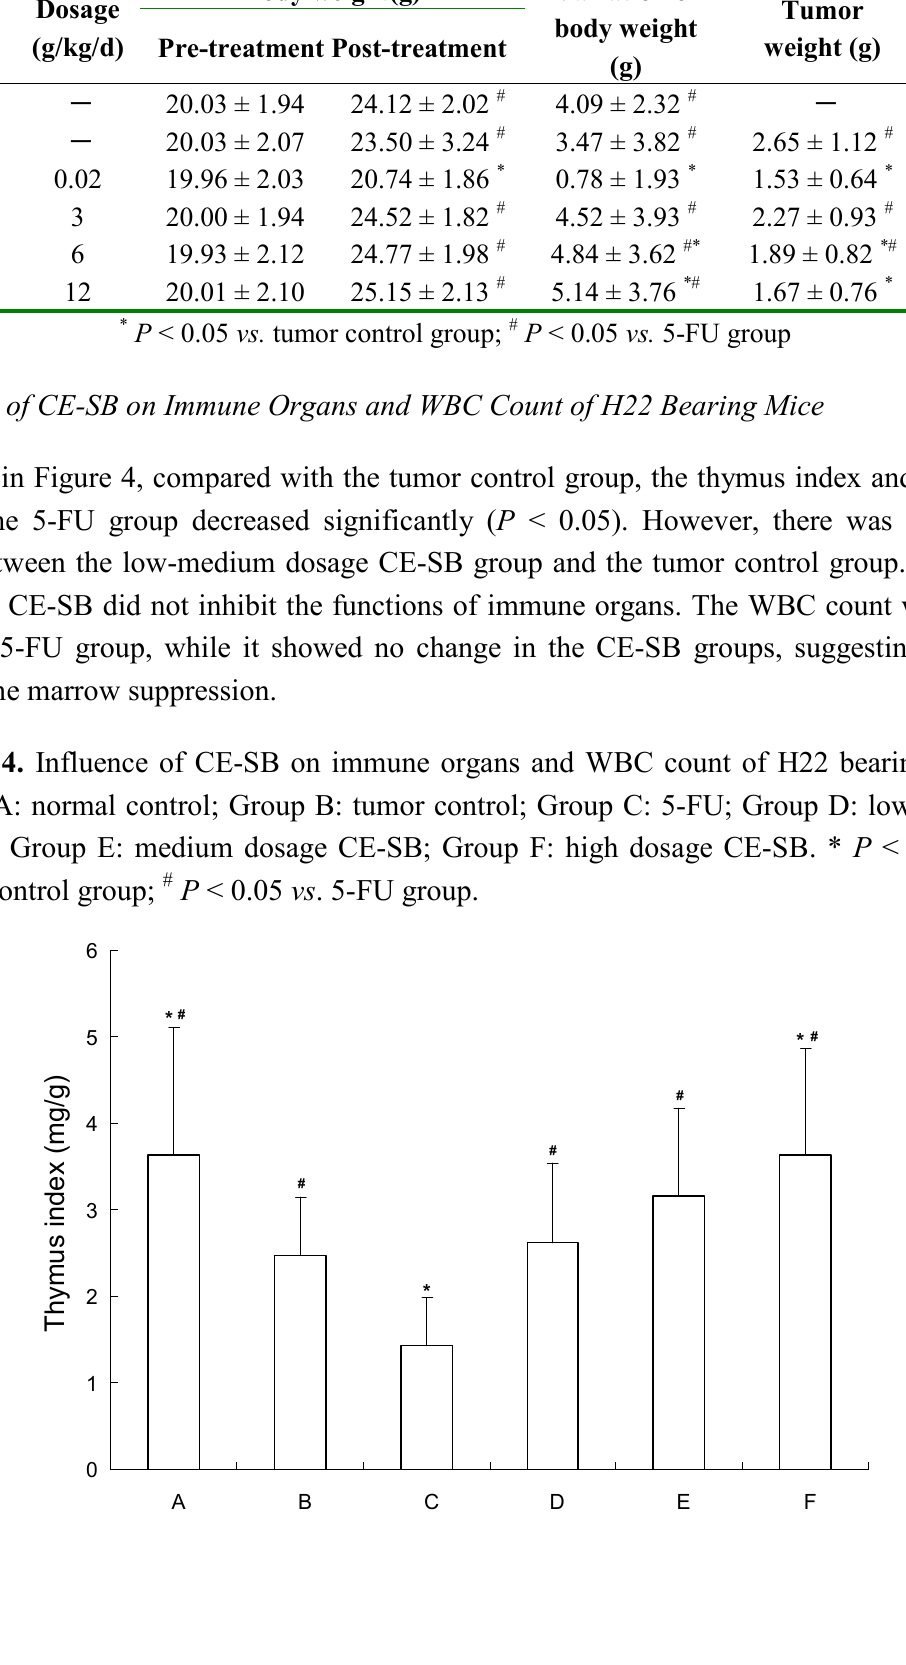
Table 1. Effects of CE-SB on body weight and tumor weight of H22 bearing mice ( x ± s, n = 10). Body weight(g) Variation of Tumor Dosage Tumor Group body weight inhibition (g/kg/d) weight (g) Pre-treatment Post-treatment (g) rate (%) Normal － 20.03 ± 1.94 24.12 ± 2.02 # 4.09 ± 2.32 # － － Tumor control － 20.03 ± 2.07 23.50 ± 3.24 # 3.47 ± 3.82 # 2.65 ± 1.12 # － 20.00 ± 1.94 24.52 ± 1.82 # 4.52 ± 3.93 # 2.27 ± 0.93 # 19.93 ± 2.12 24.77 ± 1.98 # 4.84 ± 3.62 #* 1.89 ± 0.82 *# 28.68 20.01 ± 2.10 25.15 ± 2.13 # 5.14 ± 3.76 *# 1.67 ± 0.76 * 36.98